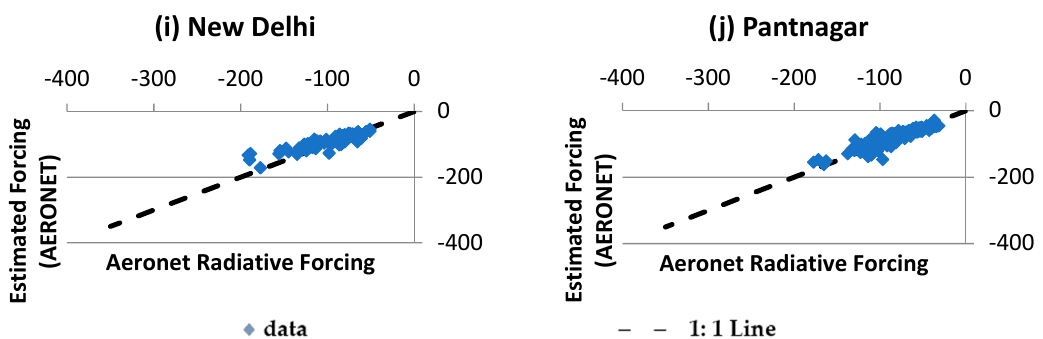
Figure 2. Evaluation of estimated radiative forcing with that of AERONET radiative forcing (Wm − 2 ) in the IGP stations. ( a ) Bhola ( b ) Dhaka University ( c ) Gandhi College ( d ) Kanpur ( e ) Karachi ( f ) Kolkata ( g ) Lahore ( h ) Lumbini ( i ) New Delhi ( j ) Pantnagar.